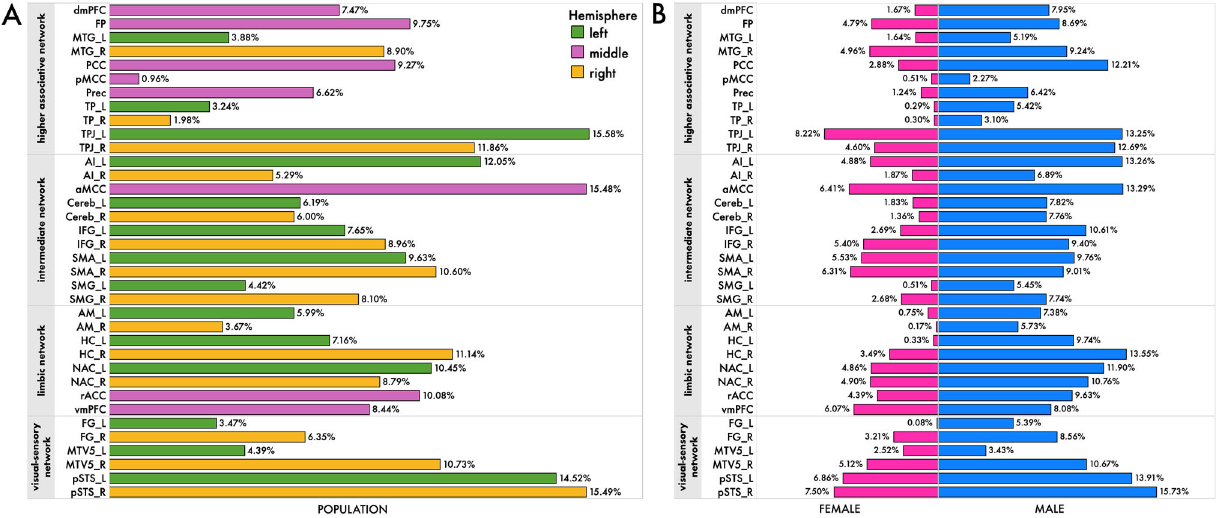
Fig. 4 Explained variance of brain-trait associations differs across social brain networks. In each of the four networks of our social brain atlas (cf. Methods; cf. Supplementary Data 2 for a description of the social brain region abbreviations), we computed posterior predictive checks for every analysis of a given target region. These model-based simulations of replicated data were then compared to the actually observed data 47 to compute the overall explained variance (coef fi cient of determination, R 2 ) for A the whole population cohort and B men and women, separately. Posterior predictive checks thus safeguarded against several important issues related to model fi t by evaluating model-simulated empirical expectations of target region volumes. Intuitively, we asked the Bayesian model: “ Based on drawing examples from the previously inferred model posterior, what should the region volume in each particular participant be given his or her 40 trait indicators? ” . We thus evaluated model-predicted data that could have been observed or will potentially be observed in the future. This practical check of model-based predictions of observations is a well-recognized approximation to external validation given the actual data at hand 48 . The collective population-level results suggest that in each of the four subnetworks of the social brain atlas, at least one region showed an explained variance of >10% in our middle-aged participant cohort. Source data are provided in Supplementary Data 3.